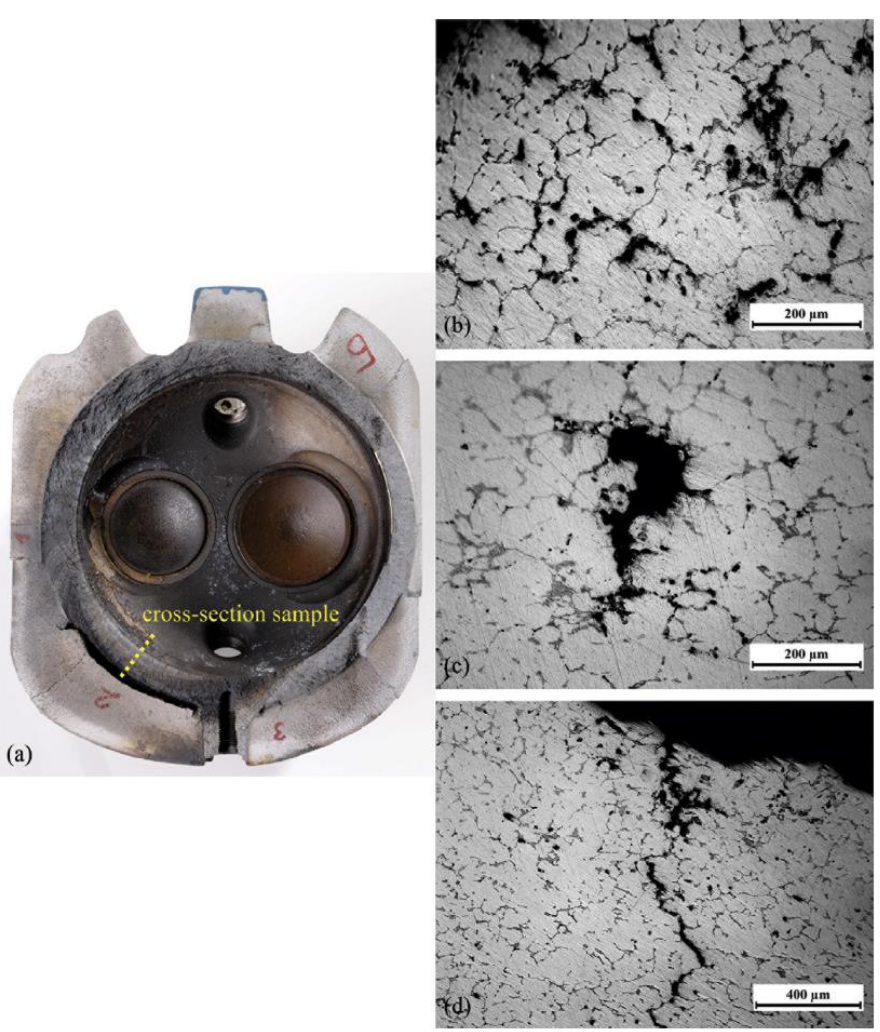
Figure 12. The failure analysis of the cylinder head that failed in service: ( a ) the failed cylinder head, ( b – d ) bifilms that were found in the area adjacent to the failed region Reprinted with permission from ref. [54]. Copyright 2022 Elsevier.